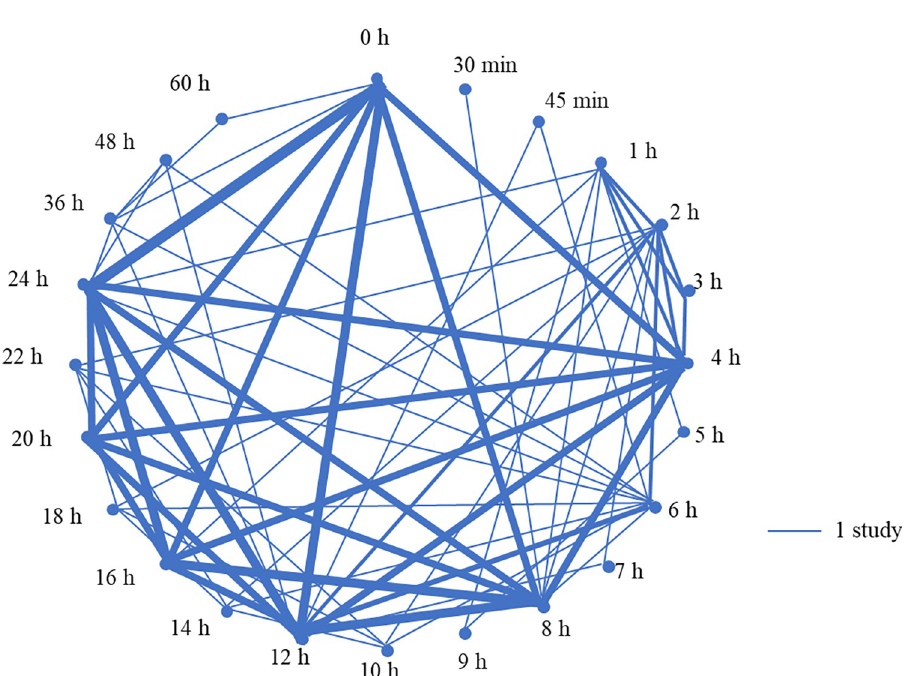
Fig 6. Schematic summary of the times compared in 21 controlled studies on the timing of first feeding of colostrum. Three studies were excluded since the timing of feeding ranged over multiple time periods or had an unclear definition. The thickness of lines represents the number of studies conducted between the combinations of treatment